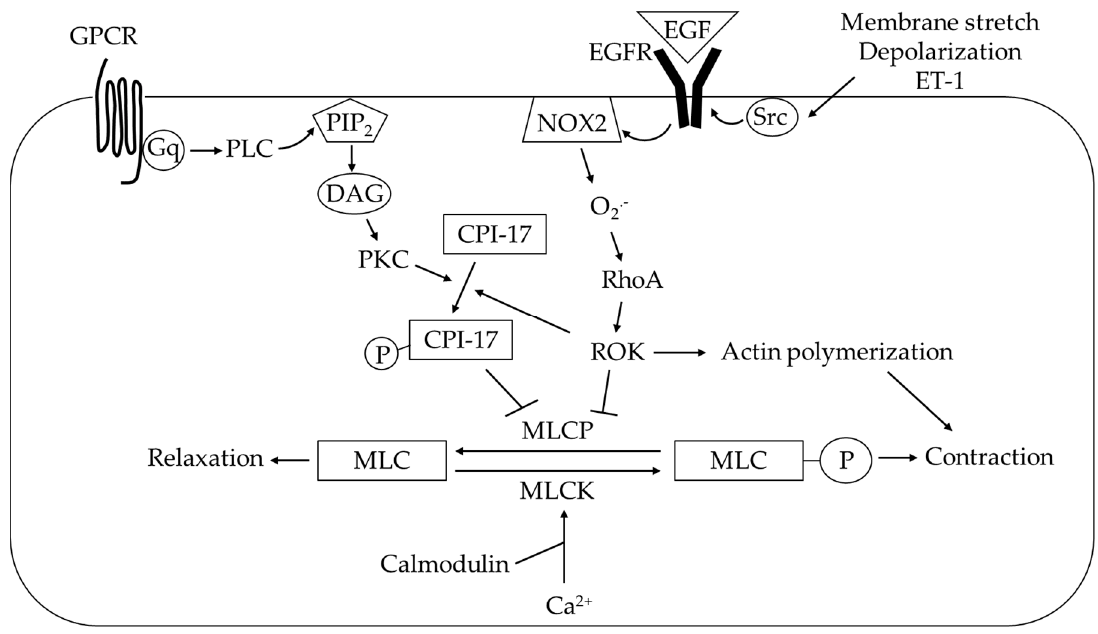
Figure 6. Summary of Ca 2+ sensitization in pulmonary arterial smooth muscle cells. Myofilament Ca 2+ sensitization is facilitated by ROS following CH. In particular, membrane stretch and endothelin 1 (ET-1) activate Src kinase-epidermal growth factor receptor (EGFR)-NADPH oxidase 2 (NOX2) signaling axis that contributes to CH-induced augmentation of Ca 2+ -independent pulmonary vasoconstriction and pulmonary hypertension. See text for details. GPCR, G protein-coupled receptor; PLC, phospholipase C; PIP 2 , phosphatidylinositol 4,5-bisphosphate; DAG, diacylglycerol; PKC, protein kinase C; O 2. − , superoxide; ROK, Rho kinase; MLCP, myosin light chain phosphatase; MLCK, myosin light chain kinase; MLC, myosin light chain.